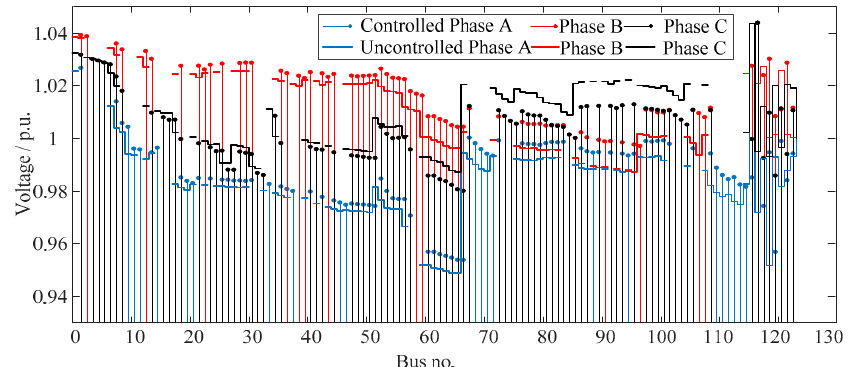
Figure 5. Power losses of distribution network with EV charging load: ( a ) Daily profile of total losses with and without EV charging control; ( b ) line losses of 123-bus power network at the peak hour.